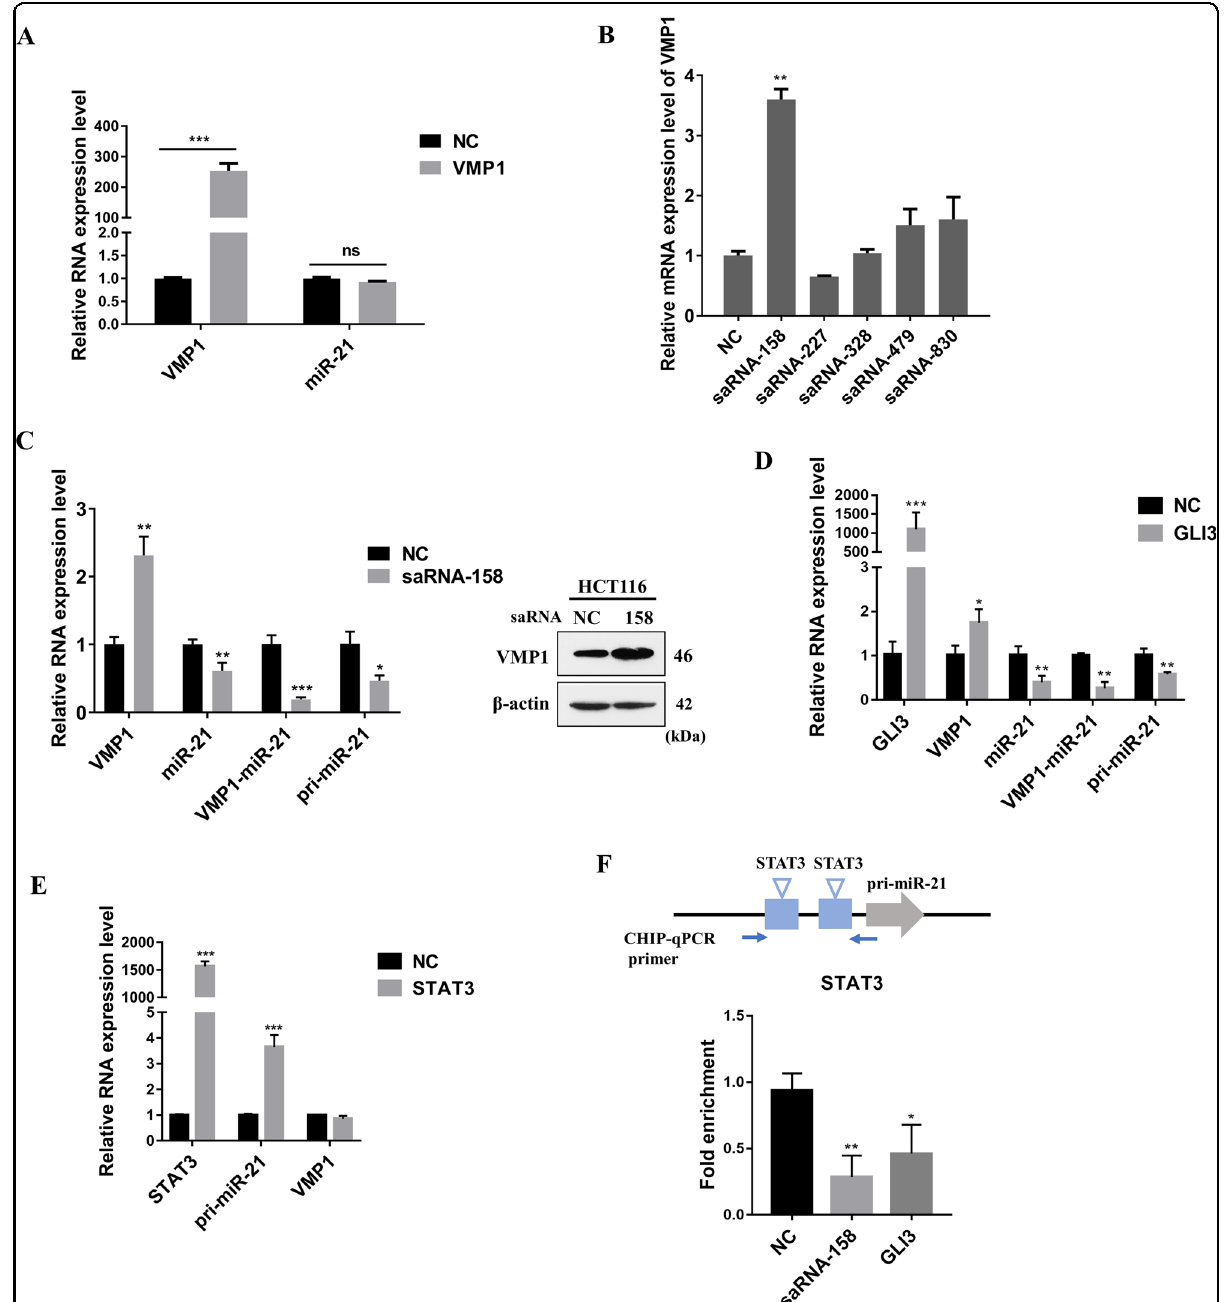
Fig. 2 Transcriptional activation of VMP1 inhibits miR-21 expression. a HCT116 was transfected with pcDNA3.1-VMP1 vector for 48 h, the mRNA expression level of VMP1 and miR-21 was measured by qPCR. b HCT116 was transfected with the small activating RNA (saRNA) targeting VMP1 promoter for 48 h, then the mRNA expression of VMP1 was measured by qPCR. c HCT116 was transfected with saRNA-158 for 48 h, the mRNA and protein expression level of VMP1 was measured by Western blot and qPCR, miR-21 expression and the number of pri-miR-21 and VMP1-miR-21 transcripts were measured by qPCR. d HCT116 was transfected with pEGFP-C3-hGLI3 vector for 48 h, the mRNA expression level of GLI3, VMP1, miR- 21, and the number of pri-miR-21 and VMP1-miR-21 transcripts were measured by qPCR. e HCT116 was transfected with pEGFP-N1-STAT3 vector for 48 h, the mRNA expression level of STAT3, VMP1, and the number of pri-miR-21 were measured by qPCR. f HCT116 was transfected with saRNA-158 and pEGFP-C3-hGLI3 vector, then CHIP-qPCR analyses using phospho-STAT3 (Tyr705) special antibody were performed. Primer speci fi c for the binding sites of STAT3 to the pri-miR-21 promoter region. Data are presented as mean ± SD. *** P < 0.001, ** P < 0.01, * P <